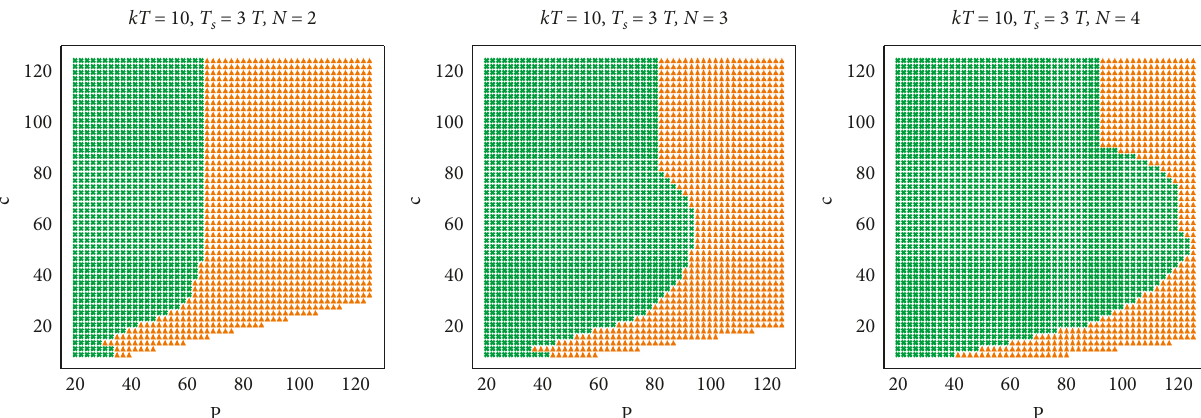
Figure 3: Comparison of the average waiting time for the three configurations as a function of the demand at the spike bus stop P and the capacity c . The orange triangles represent the set of parameters where synchronised bunched buses have the lowest average waiting time, while the green “ x ” symbols indicate where perfectly staggered buses have the lowest average waiting time among the three configurations. Bunched buses (case A) are never the best performers for the parameters explored. The three plots show how increasing the number of buses from 2 to 3 to 4 (from left to right) tends to favour the staggered bus configuration. Points in the region of high P and low c are missing, since in that regime more than two revolutions are needed to pick up all the passengers at the spike bus stop . This region is defined by c < P / ( 2 N ) . For this example, T is set to a value of 100 time units and T s � 3 T while k is fixed at